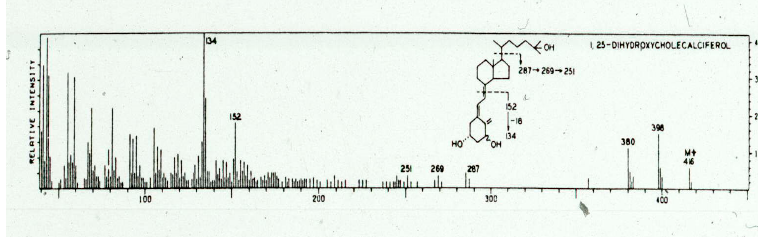
Figure 11. The mass spectrum of the purified metabolite demonstrated a molecular ion of 416 m / e consistent with an additional hydroxyl group on the metabolite. The fragments of 152 and 134 revealed that the hydroxyl group was somewhere in the A ring, most likely on carbon 1. Several chemical reactions were performed on nanogram quantities of the pure metabolite that provided evidence that the extra hydroxyl group was on carbon 1. Holick copyright 2023. Reproduced with permission.